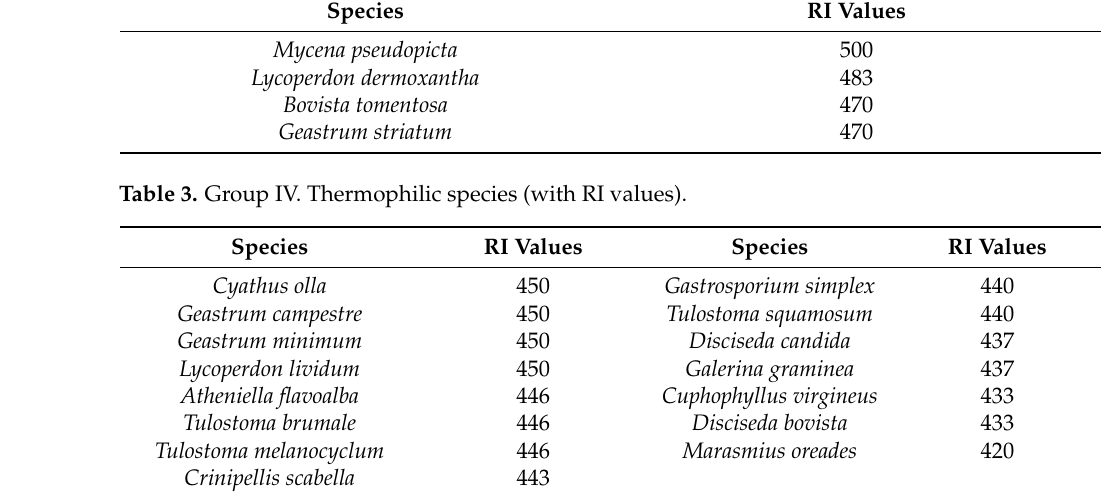
Table 2. Group III. Moderately xerothermic species (with RI values). Species RI Values Mycena pseudopicta